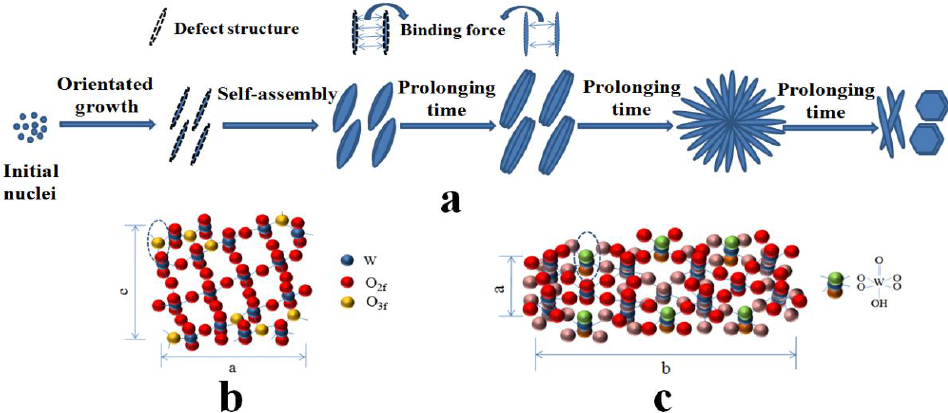
Figure 5. Schematic illustrations: ( a ) the possible formation mechanism of the products obtained at different reaction time; ( b ) the crystal structure of W 18 O 49 ; ( c ) the crystal structure of WO 3 ·0.33H 2 O.